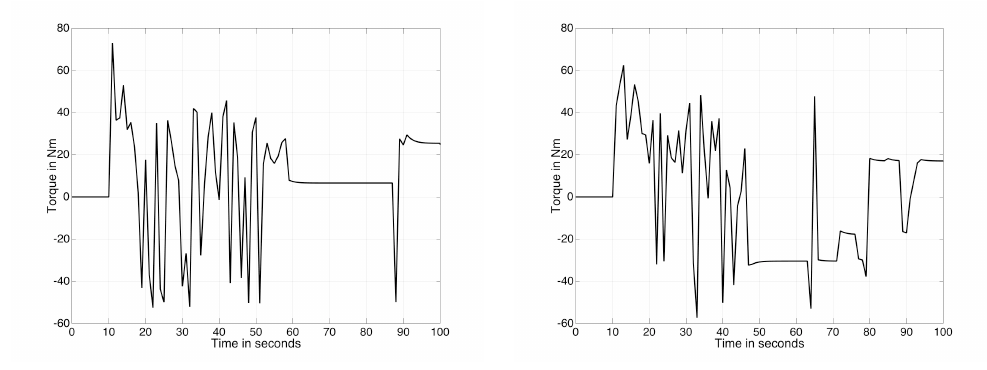
Figure 8. Step response of the